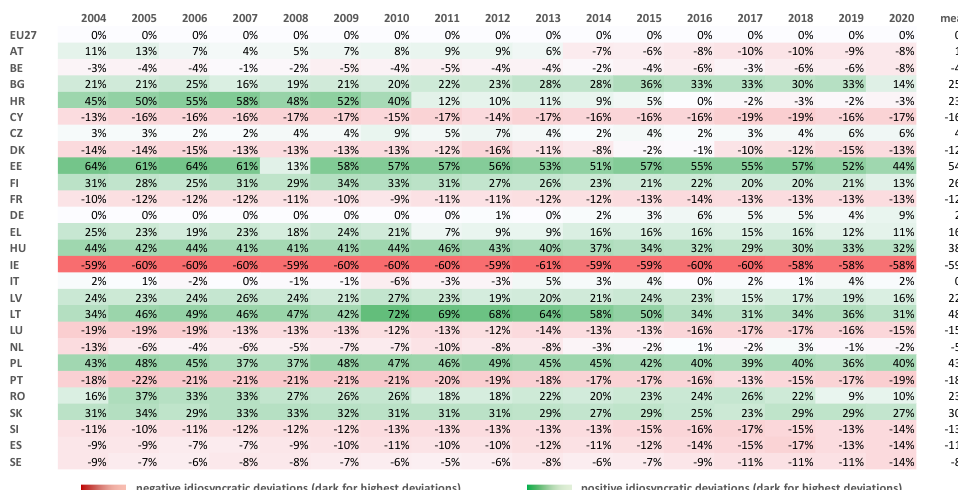
Figure 4. IDRs. Figure 4.